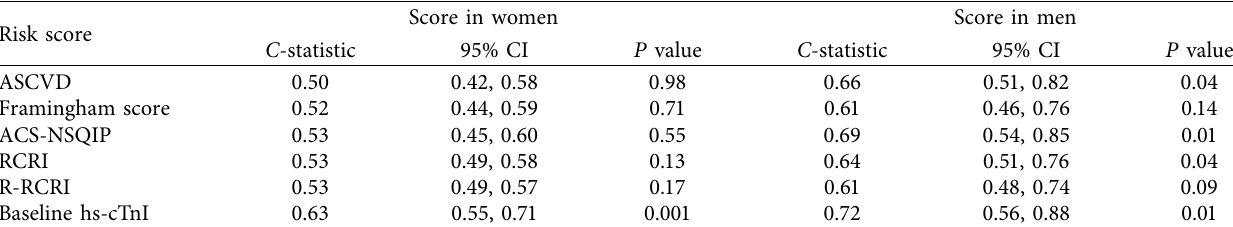
Table 2: C -statistics of scores and p values for prediction of